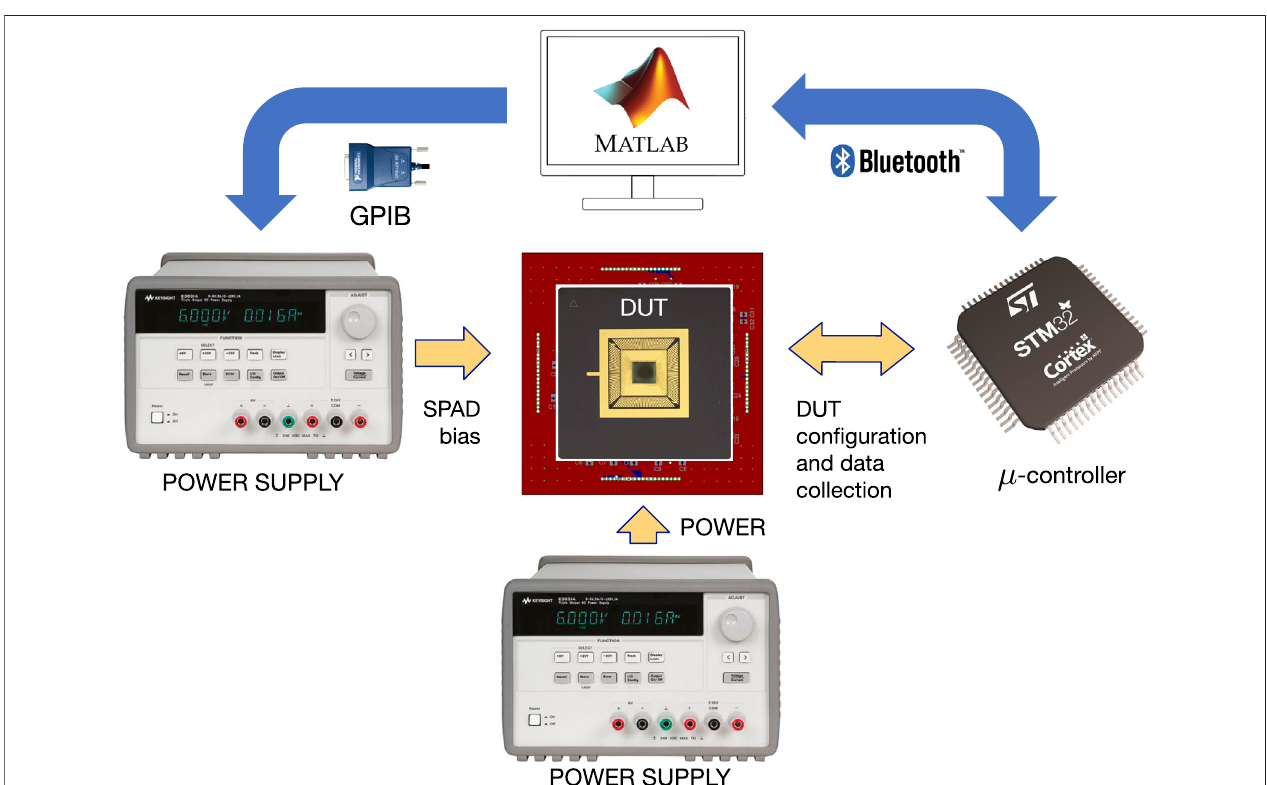
FIGURE 6 | Schematic representation of the measurement setup used for DCR characterization of the DUTs.